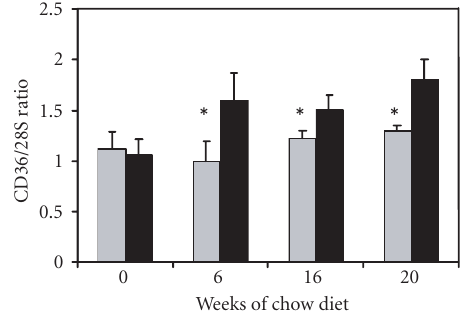
(a) Representativewestern blot of CD36 proteinexpression in heartsof chow fed apoE − / − mice, in comparison to wild type (C57BL/6). Blots contained50 µ gofmembraneproteins.The0,6,16,and20correspond to the number of weeks of chow diet. A control for loading and quan- tification was also used on the Coomassie gel (not shown).